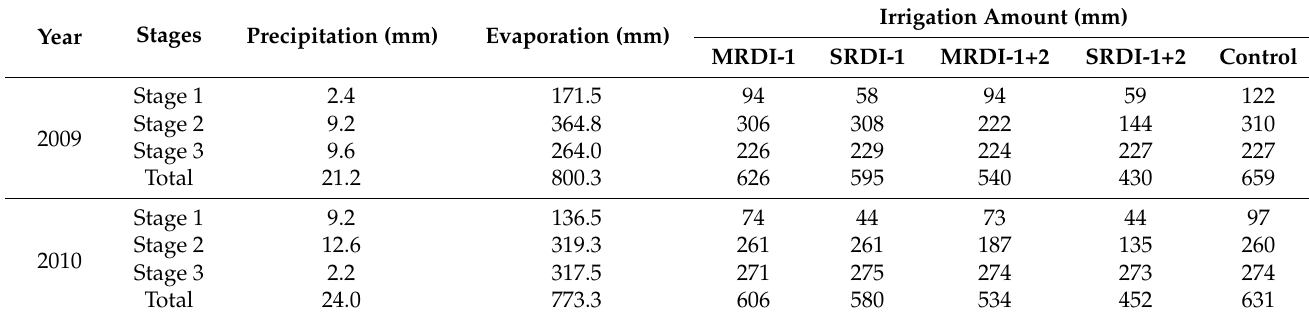
Table 1. Precipitation, evaporation, and irrigation amount of each